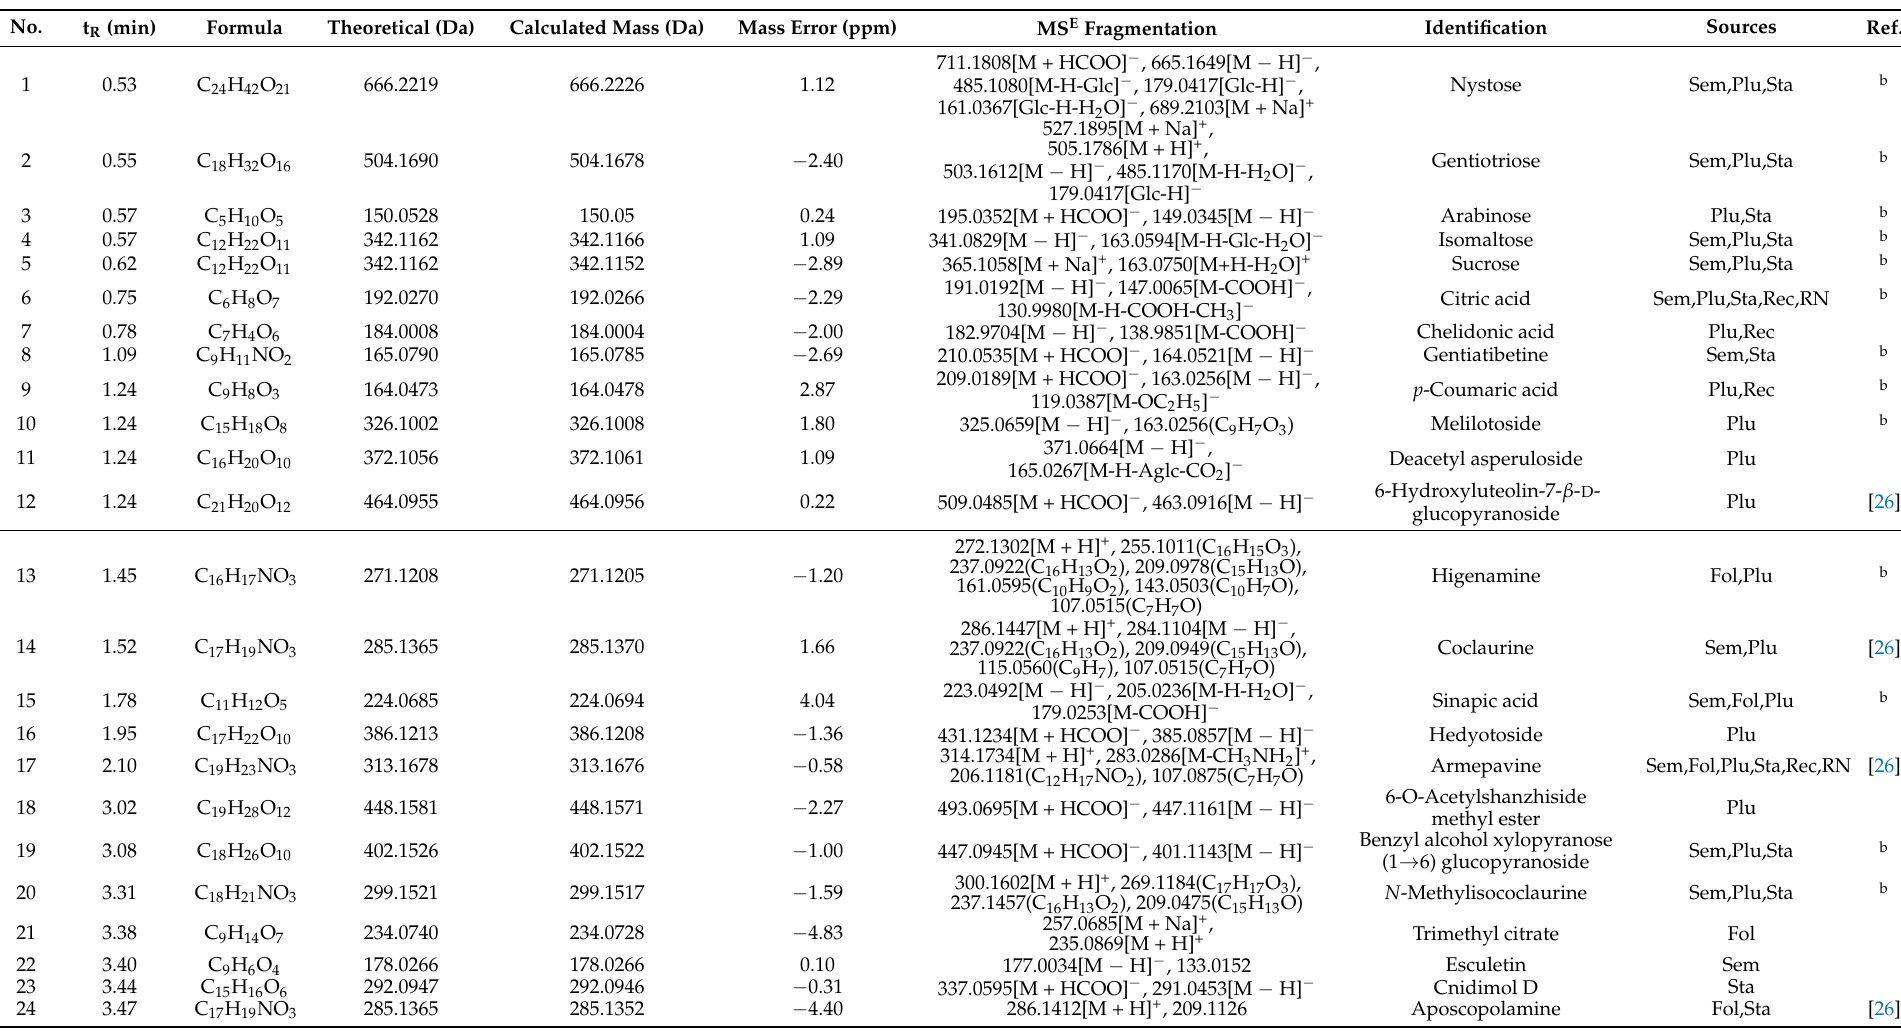
Table 1. Compounds identified from different parts of lotus by UPLC-QToF-MS E